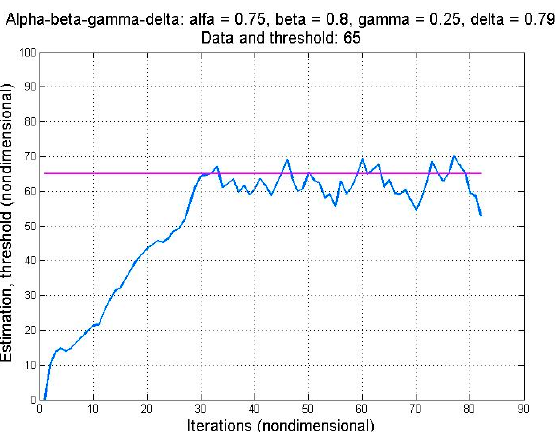
Figure 10. The estimated value of the α – β – γ – δ filter exceeds the threshold at iteration